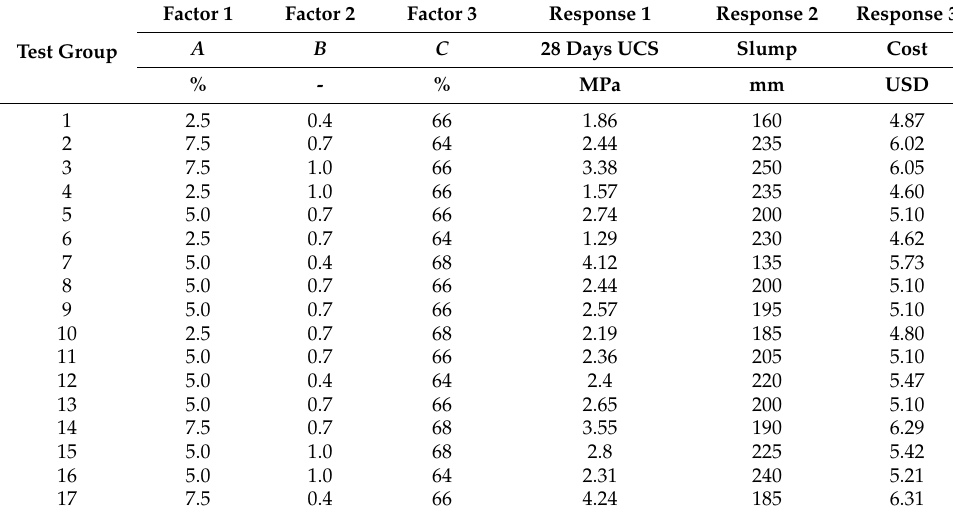
Table 5. Experimental BBD